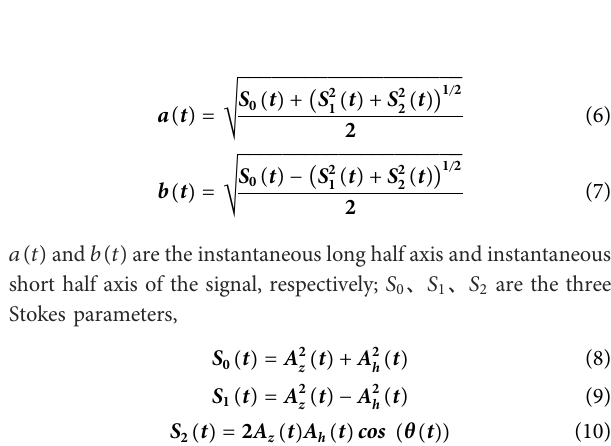
homogeneous half-space model; (B – D) are seismic records after polarization fi ltering with parameters of 0.1, 0.3 and 0.4 respectively.